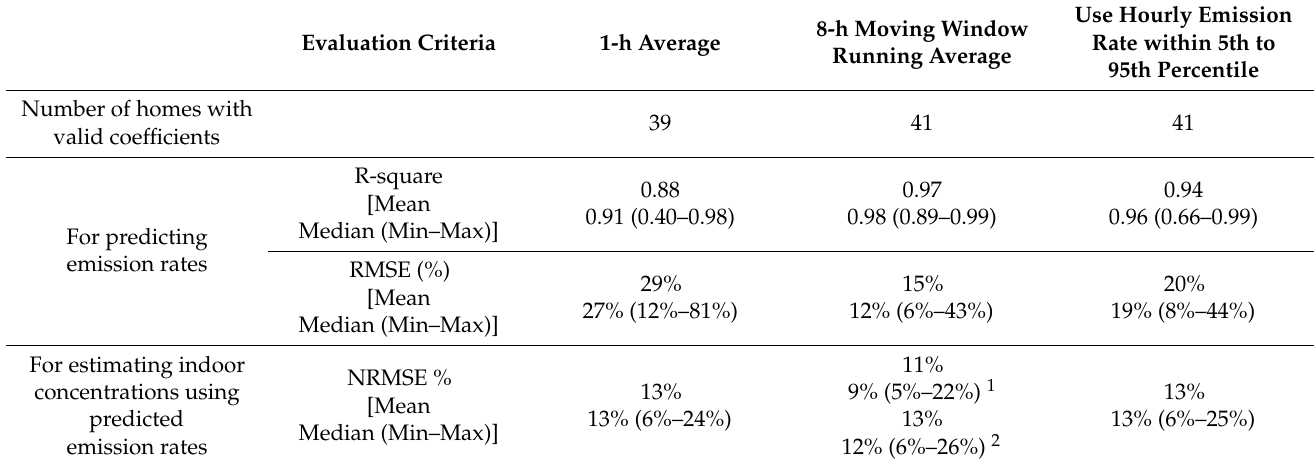
Table 1. Summary of regression performance